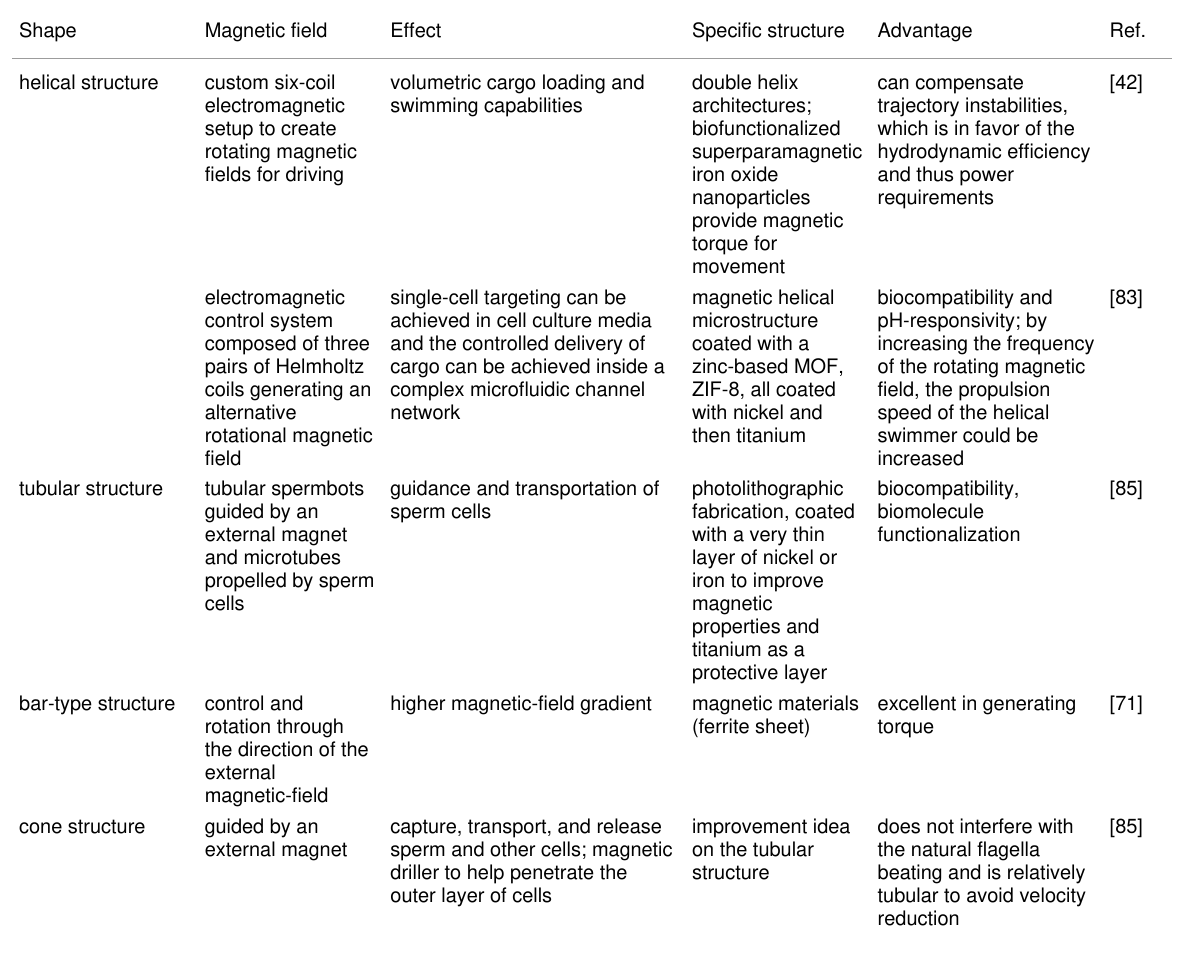
Table 3: Magnetic drive structures of different shapes.